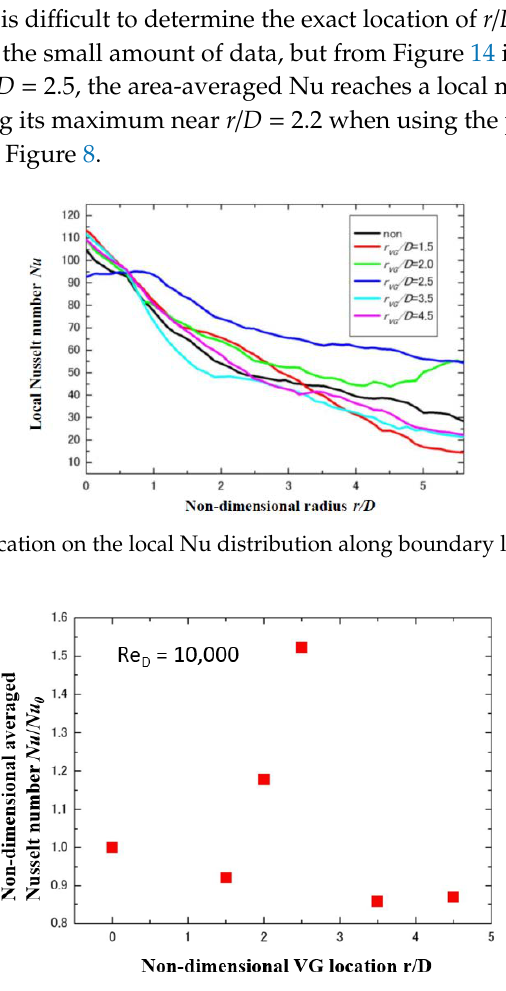
Figure 14. Effect of VG location on the averaged Nu (fixed VG height: e / δ = 1.0). Figure 14. E ff ect of VG location on the averaged Nu (fixed VG height: e / δ =